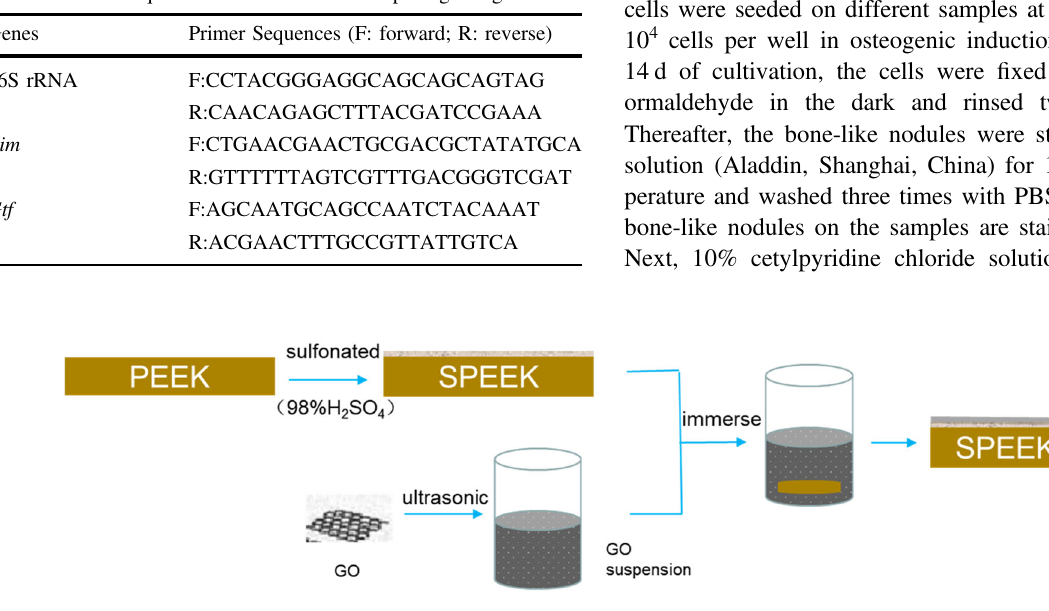
Fig. 1 Schematic diagram showing the surface modi fi cation process of PEEK. PEEK is sulfonated with 98% H 2 SO 4 to get SPEEK and the deposition of GO to obtain the SPEEK-GO specimens